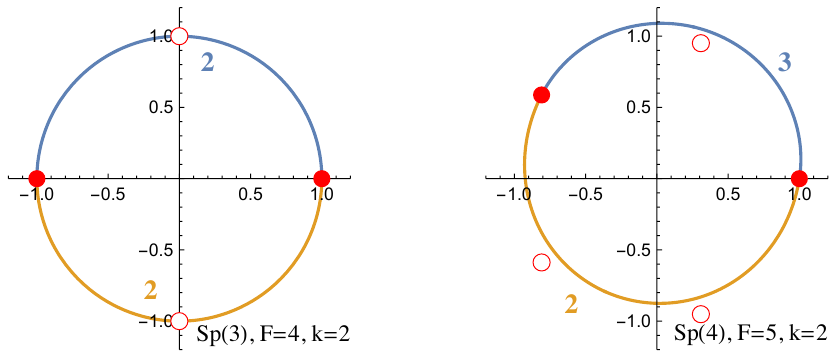
Figure 2 . Examples of 2-walls in Sp( N ) SQCD with F = N + 1 couples of flavors. The notation is as in figure 1.